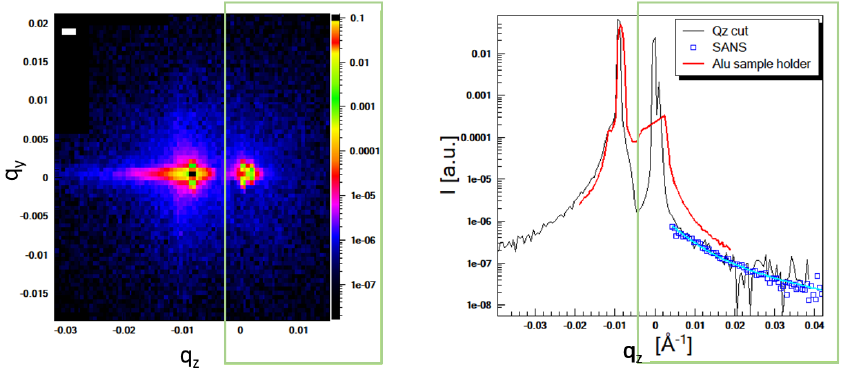
Figure 5. Left : Detector image of microgels at interfaces with the new cell: the GISANS part (left side of the detector) and the SANS part around the transmitted beam (within green frame). Right : Line cuts of the detector images along q z at q y = 0 (black line), compared to the data measured with Al cell (red line). A significantly reduced background signal is obtained. The radially averaged SANS intensity of the right side of the detector is shown as blue squares with a fit with an Ornstein– Zernike